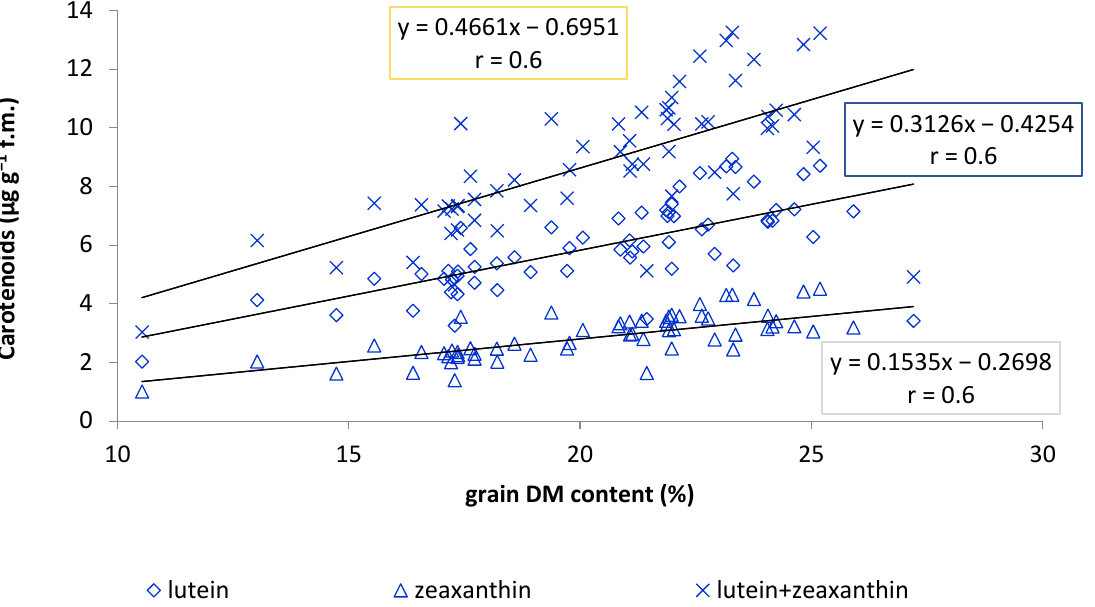
Figure 5. Regression curve between grain dry matter content (DM) and carotenoids content µg g −1 f.m).